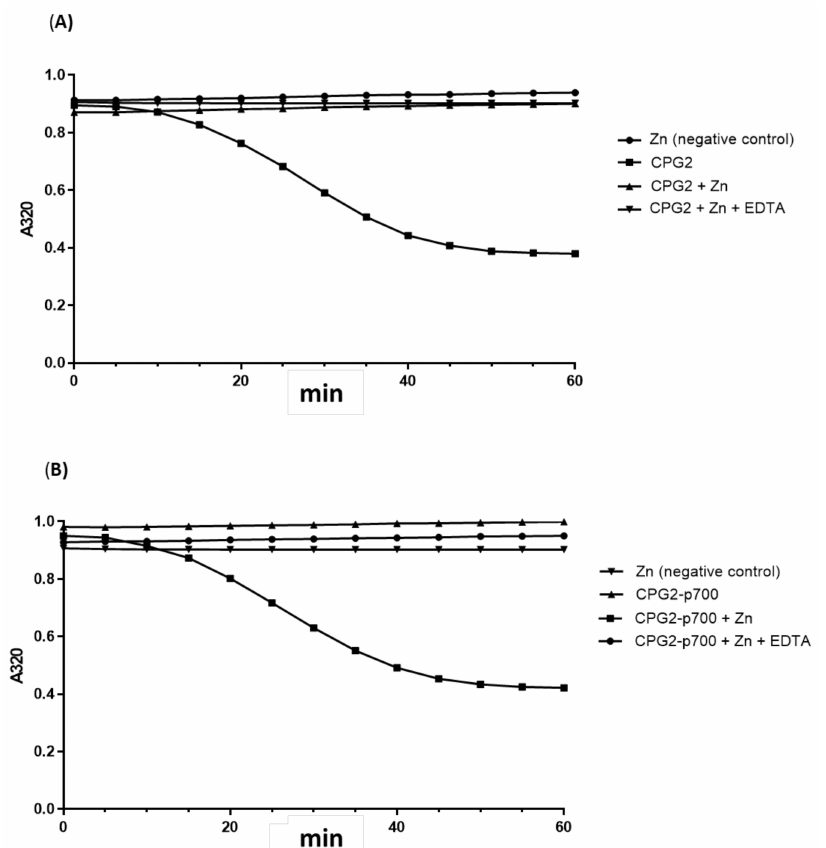
Figure 4. Confirmation of the zinc-dependent enzymatic activity of purified recombinant CPG2 proteins. Recombinant proteins were incubated with methotrexate at 37 ◦ C for 0–60 min. The absorbance of each reaction at 320 nm was plotted against time. A similar reduction in absorbance (representing catalysis of MTX) was seen for both CPG2 ( A ) and CPG2-p700 ( B ) in the presence of ZnSO4 but not in its absence nor when the zinc chelating agent, EDTA, was